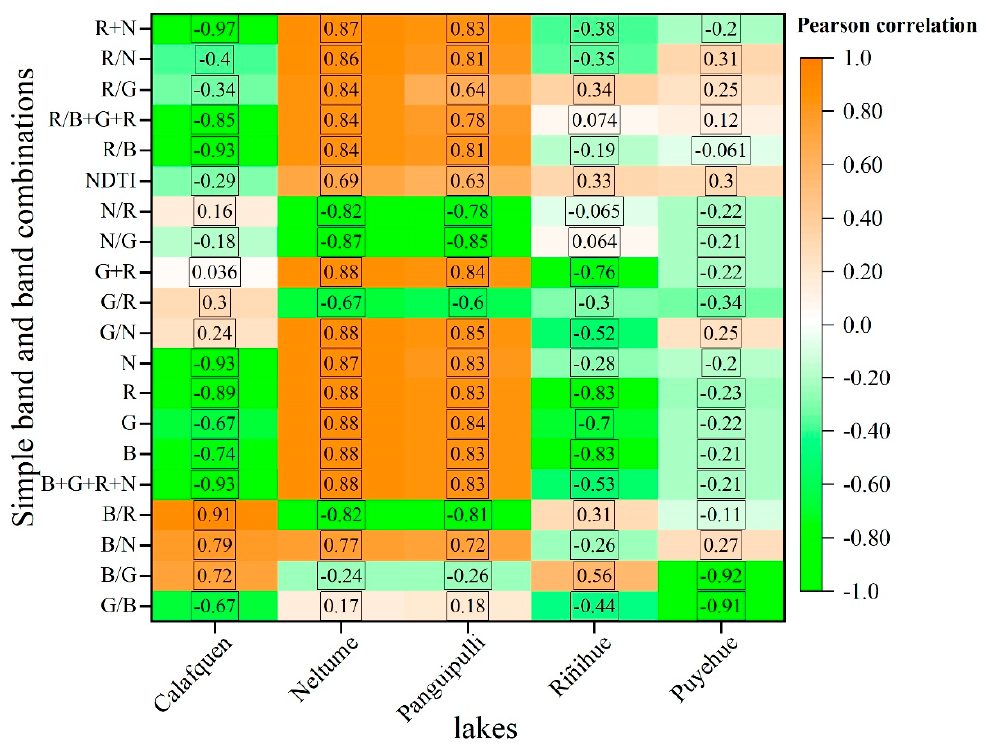
Figure 3. Pearson’s r correlation between turbidity, individual bands, band combinations, and Normalized Difference Turbidity Index (NDTI) for each lake.